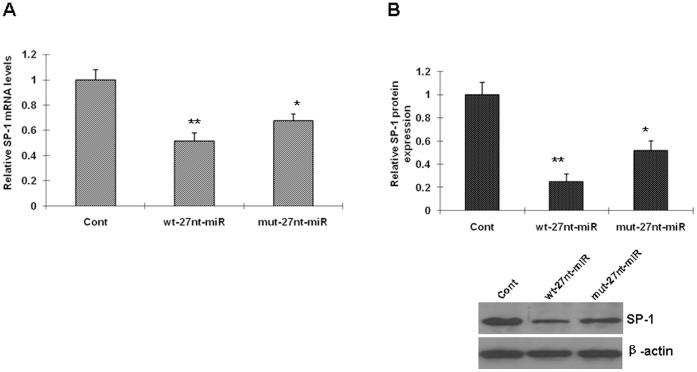
Sp-1 expression is negatively regulated by miRNA.The stable endotheial cell lines transfected with the wild-type 27-nt-miRNA, mutant 27-nt-miRNA, or the control plasmids were used for analysis of Sp-1 expression. Sp-1 mRNA and protein were measured by RT-PCR and Western Blotting, respectively. Cont, cells transfected with control plasmid; wt-27nt-miR: cells transfected with plasmid expressing wild-type 27-nt-miRNA; mut-27nt-miR: cells transfected with plasmid expressing mutant 27-nt-miRNA. *, P<0.05; **, P<0.01 vs control (n = 3).